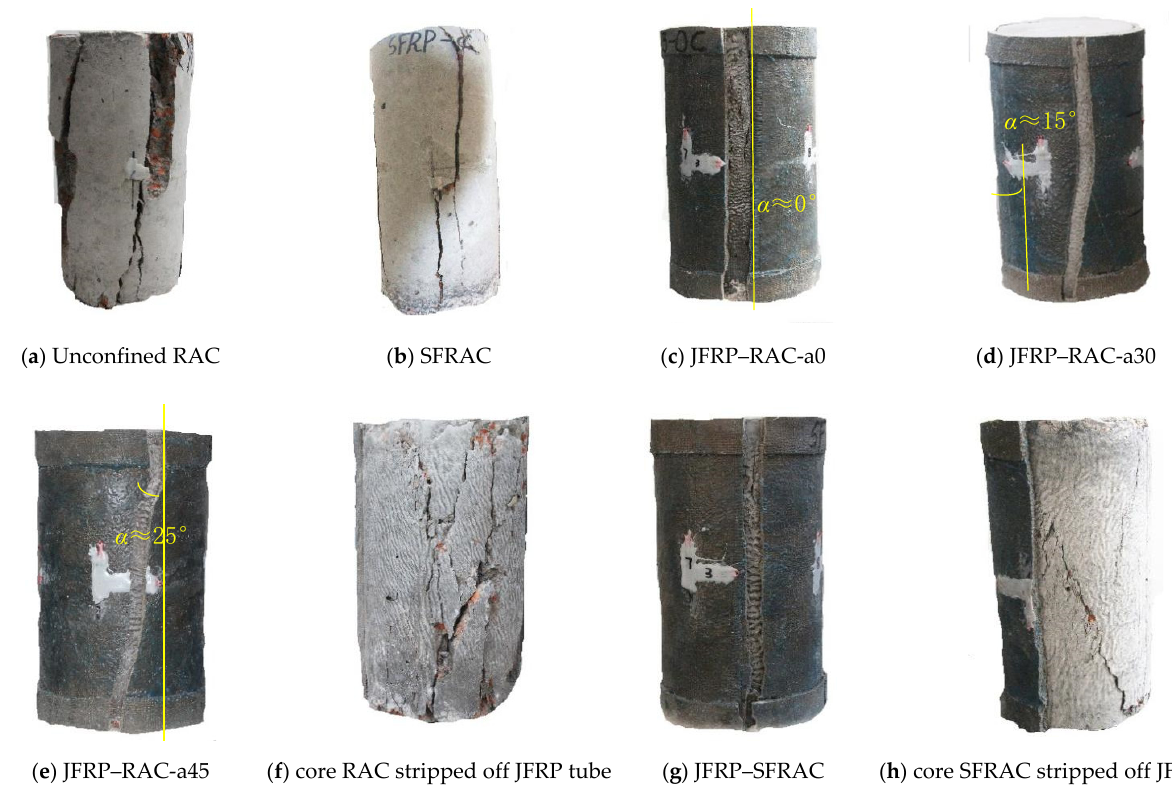
Figure 6. Failure modes of different type of samples